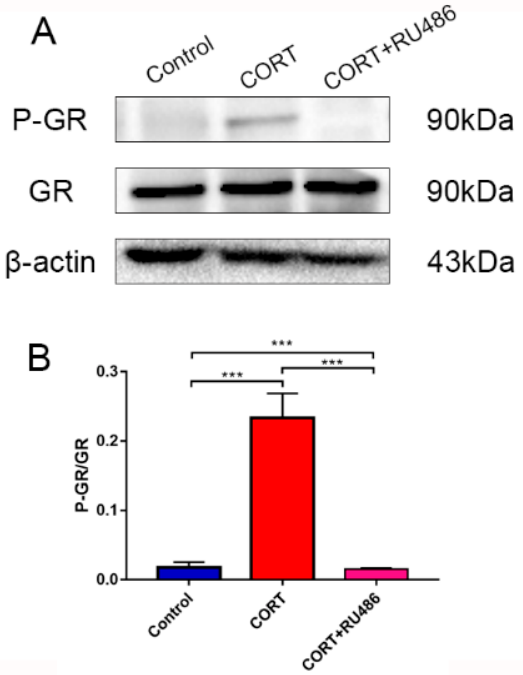
Figure 3. The relevant expression of protein in HT22 cell lysates after cortisol treatment for 3 h with RU486 or not as assessed by western blotting and relative density analysis ( A ) GR, P-GR, and β -actin expression in each group. Expression levels were quantitated by measuring band intensities using Image Lab software. The graphs indicate densitometric analyses using the expression ratios of ( B ) P-GR/GR. The results are expressed as the mean ± SD (n = 3) in each independent experiment analyzed by one-way analysis of variance. *** p < 0.001.